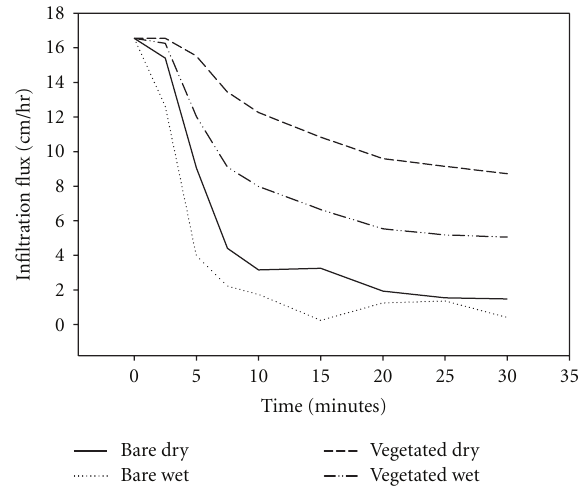
Figure 1: Infiltration flux for the Stellar soil under bare dry, bare wet, vegetated dry, or vegetated wet conditions on the Sierra Blanca Ranch.